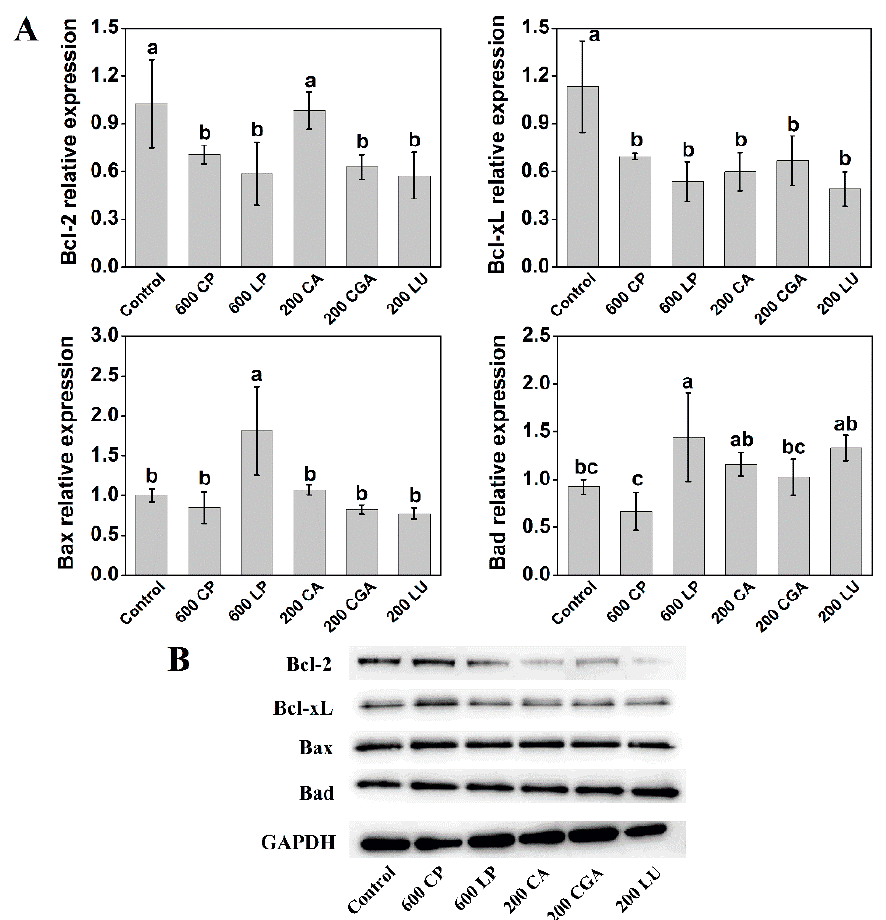
Figure 6. E ff ects of lettuce extracts and pure individual phenolic compounds on the expression of Bcl-2, Bcl-xL, Bax, and Bad as evaluated by RT-PCR analyses ( A ) and Western blotting ( B ), respectively, in Caco-2 cells. The relative transcript levels are given as a fold change relative to the control. Di ff erent letters indicate significant di ff erence at P < 0.05.